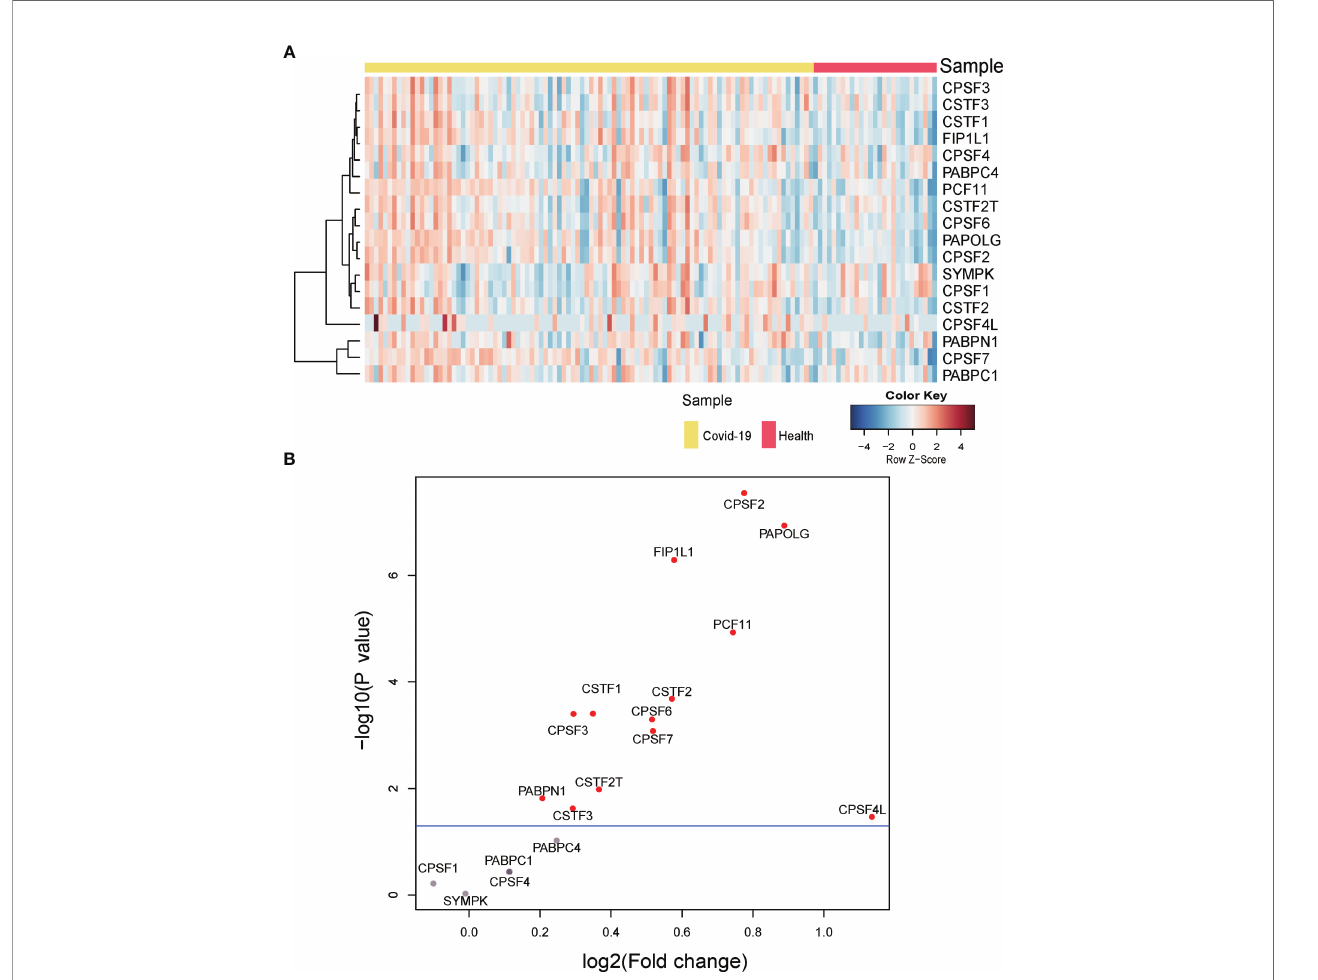
FIGURE 5 | Gene expression of APA regulators. (A) Heatmap of gene expression of regulators of APA. (B) Volcano plot of differentially expressed APA regulators. Signi fi cant regulators (p value ≤ 0.05) are highlighted in